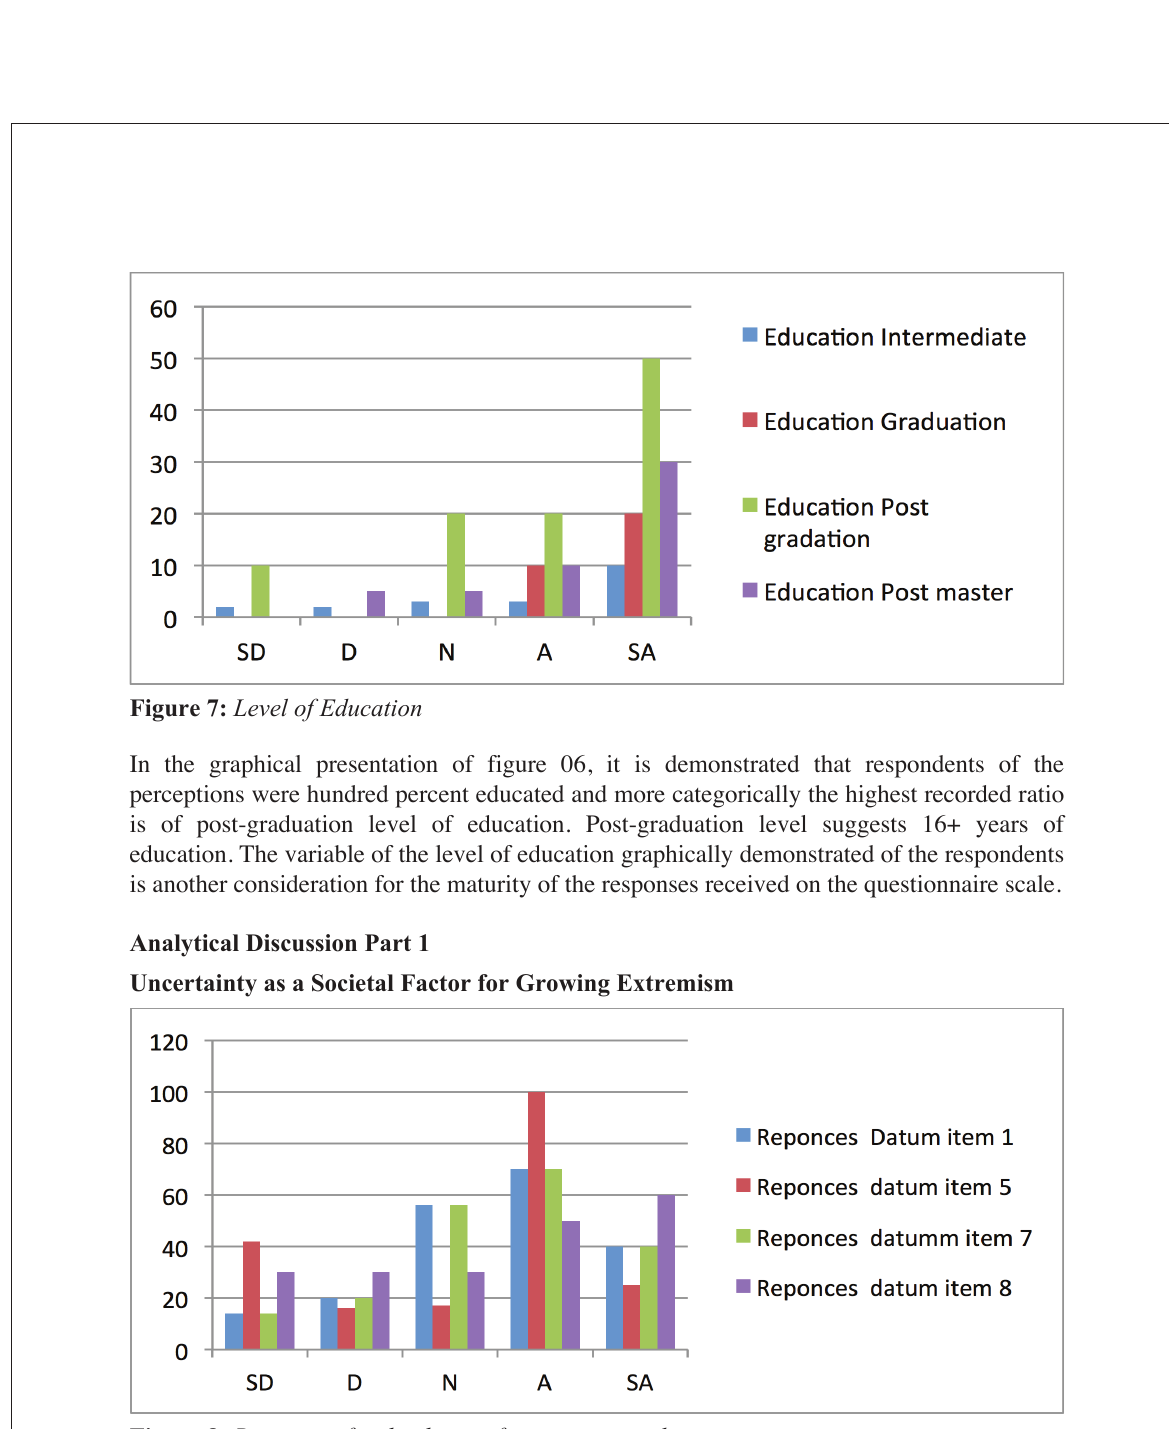
Figure 8: Responses for the theme of uncertainty and extremism